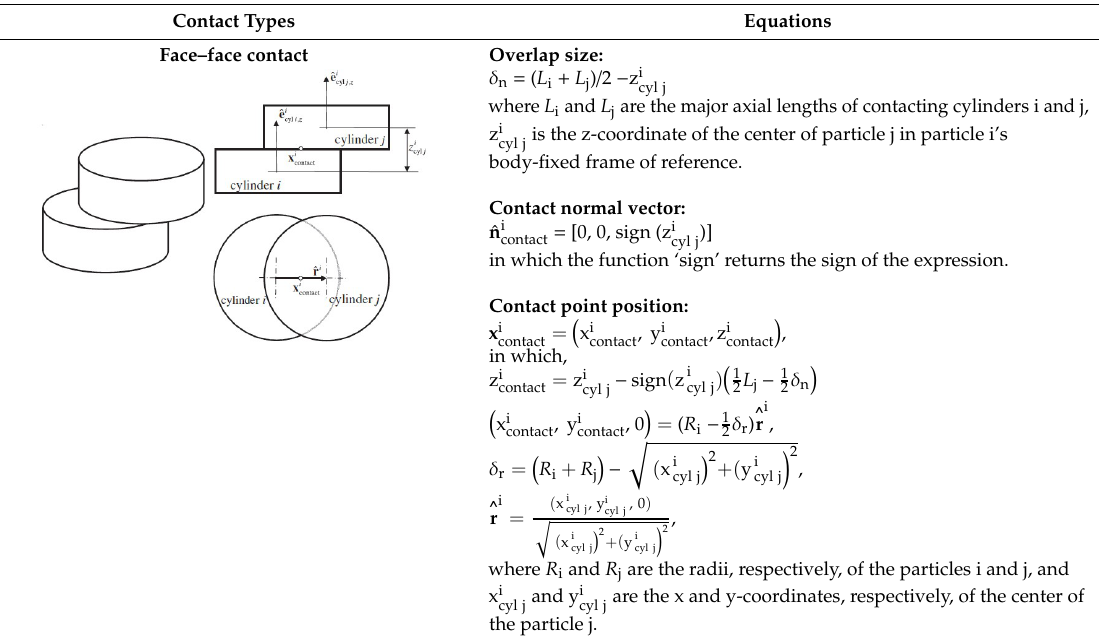
Table A1. Determination of overlap size, contact normal vector, and contact point position for the basic contact types between two cylindrical particles. The equations, which can be found in [24], are defined in particle i ’s body-fixed frame of reference. The contact detection algorithms for several special contact scenarios are referred to [25].